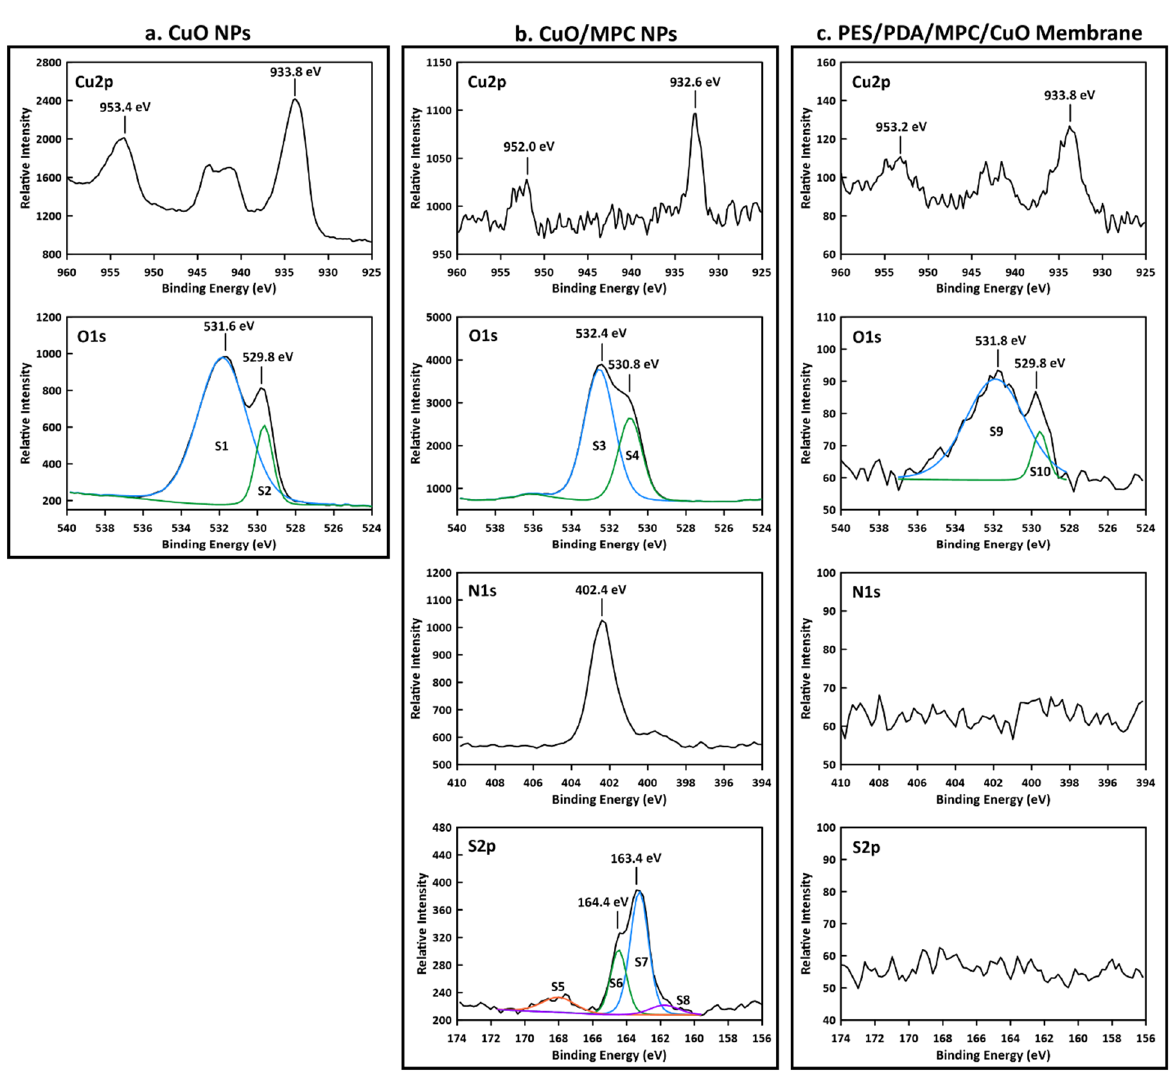
Figure 5. XPS spectra of nanoparticle and membrane samples. ( a ) CuO NPs spectra show peaks in the Cu 2p and O 1s regions consistent with copper (II) oxide. ( b ) CuO/MPC NPs spectra contain Cu2p 1/2 and Cu2p 3/2 peaks that are shifted to lower binding energy due to Cu-S bonds formed between the CuO NPs and MPC-SH. O 1s region peaks are from the C-O and C=O bonds in MPC-SH and an N 1s peak is from the alkyl ammonium group in MPC-SH. S 2p region peaks arise from oxidized sulfur (S5), C-S-C bonds (S6 and S7) and Cu-S bonds between CuO NPs and MPC-SH (S8). ( c ) PES/PDA/MPC/CuO membrane spectra contain peaks at virtually the same positions in the Cu 2p and O 1s regions as for CuO NPs and have no apparent peaks in the N 1s or S 2p regions, indicating that the CuO NPs cover the surface.